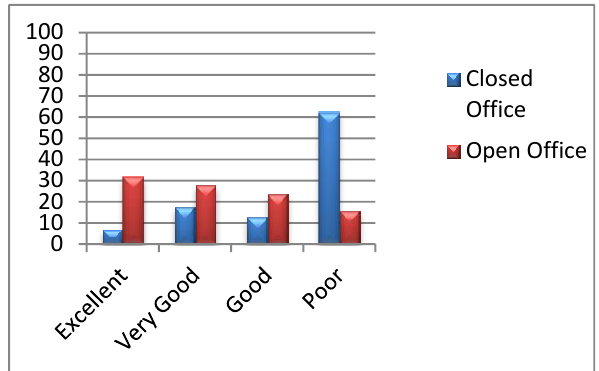
Figure 3. Level of interraction with colleagues in closed and open office. Source: (Author,